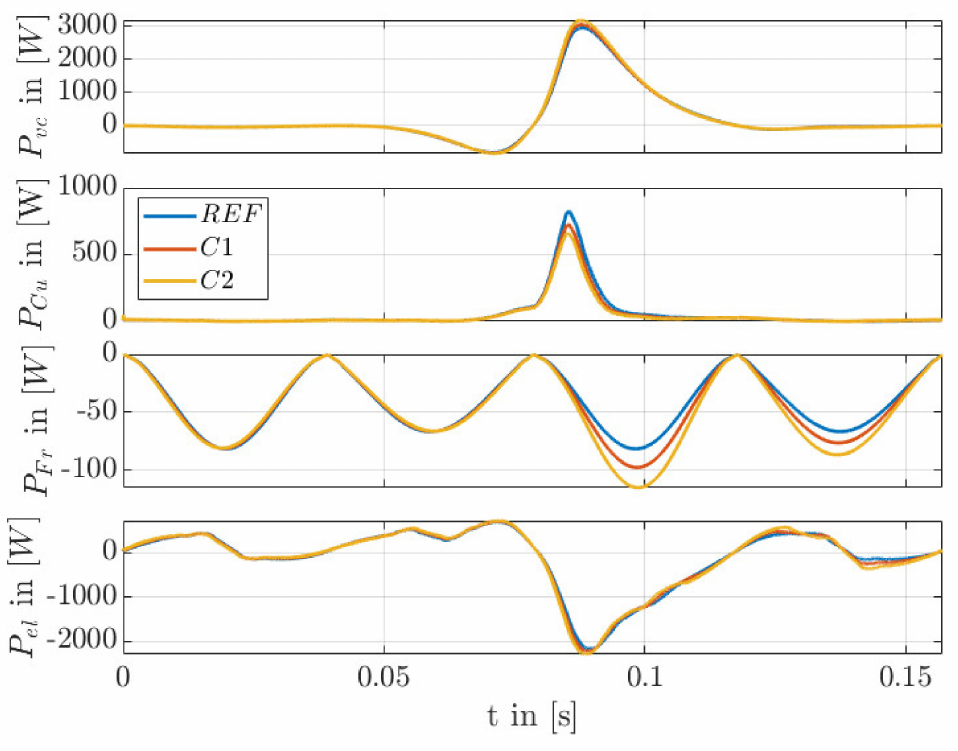
Figure 28. Comparison of trajectories REF, C1 and C2 related to the energy conversion of the electrical machine: volume change power, copper power losses, friction power losses and electric power depending on